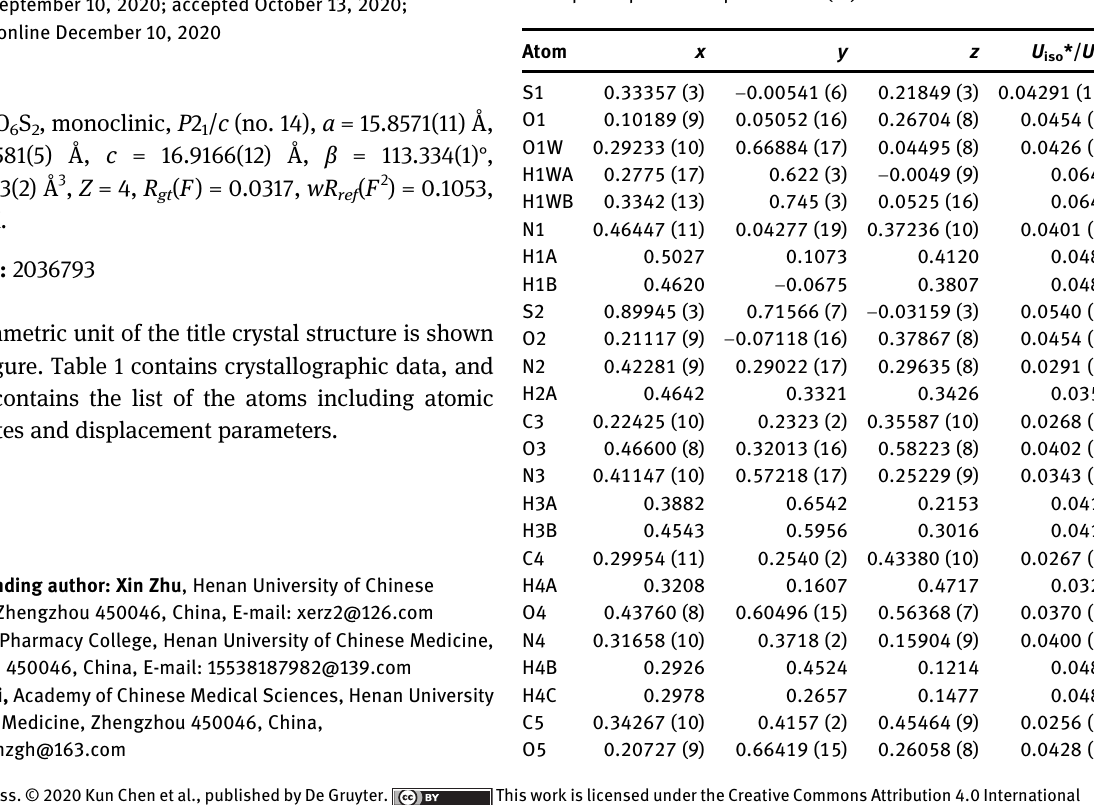
Table  : Fractional atomic coordinates and isotropic or equivalent isotropic displacement parameters (Å 